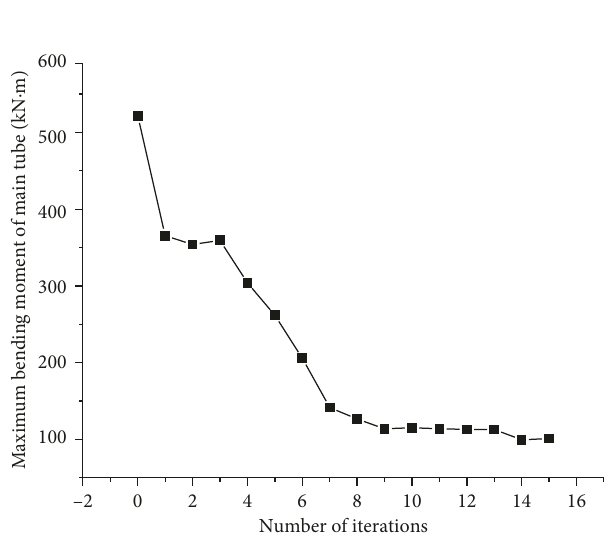
Figure 8: Maximum bending moment of the main tube.